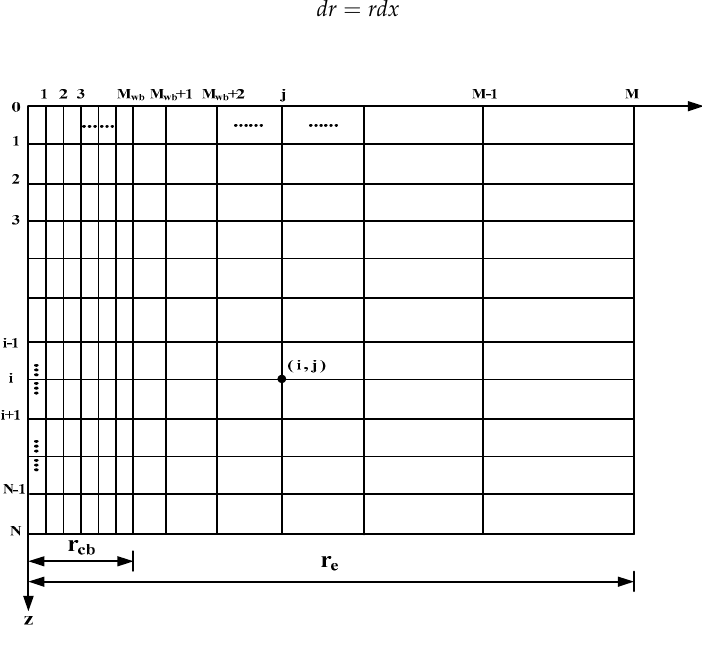
Figure A1. schematic of the downhole mesh generation.